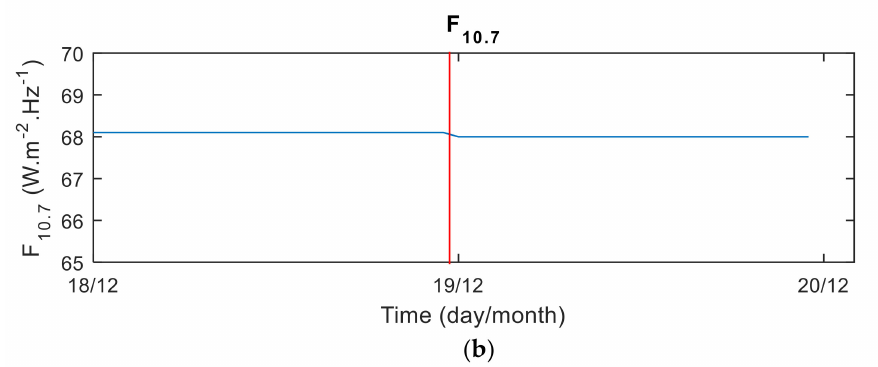
Figure 3. EVU observations ( a ) and F10.7 indicators ( b ) for the period from 18 to 19 December 2018. The red line is the moment of the meteor explosion.